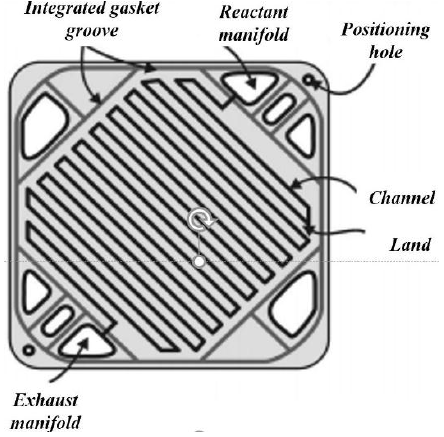
Figure 2. C onstituents of a typical bipolar plate [10].